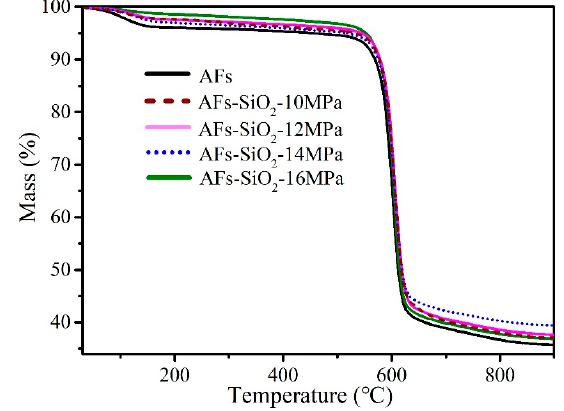
Figure 7. TGA curves of untreated fibers and modified fibers. Table 2. Residual mass of the aramid fibers treated in Sc-CO 2.